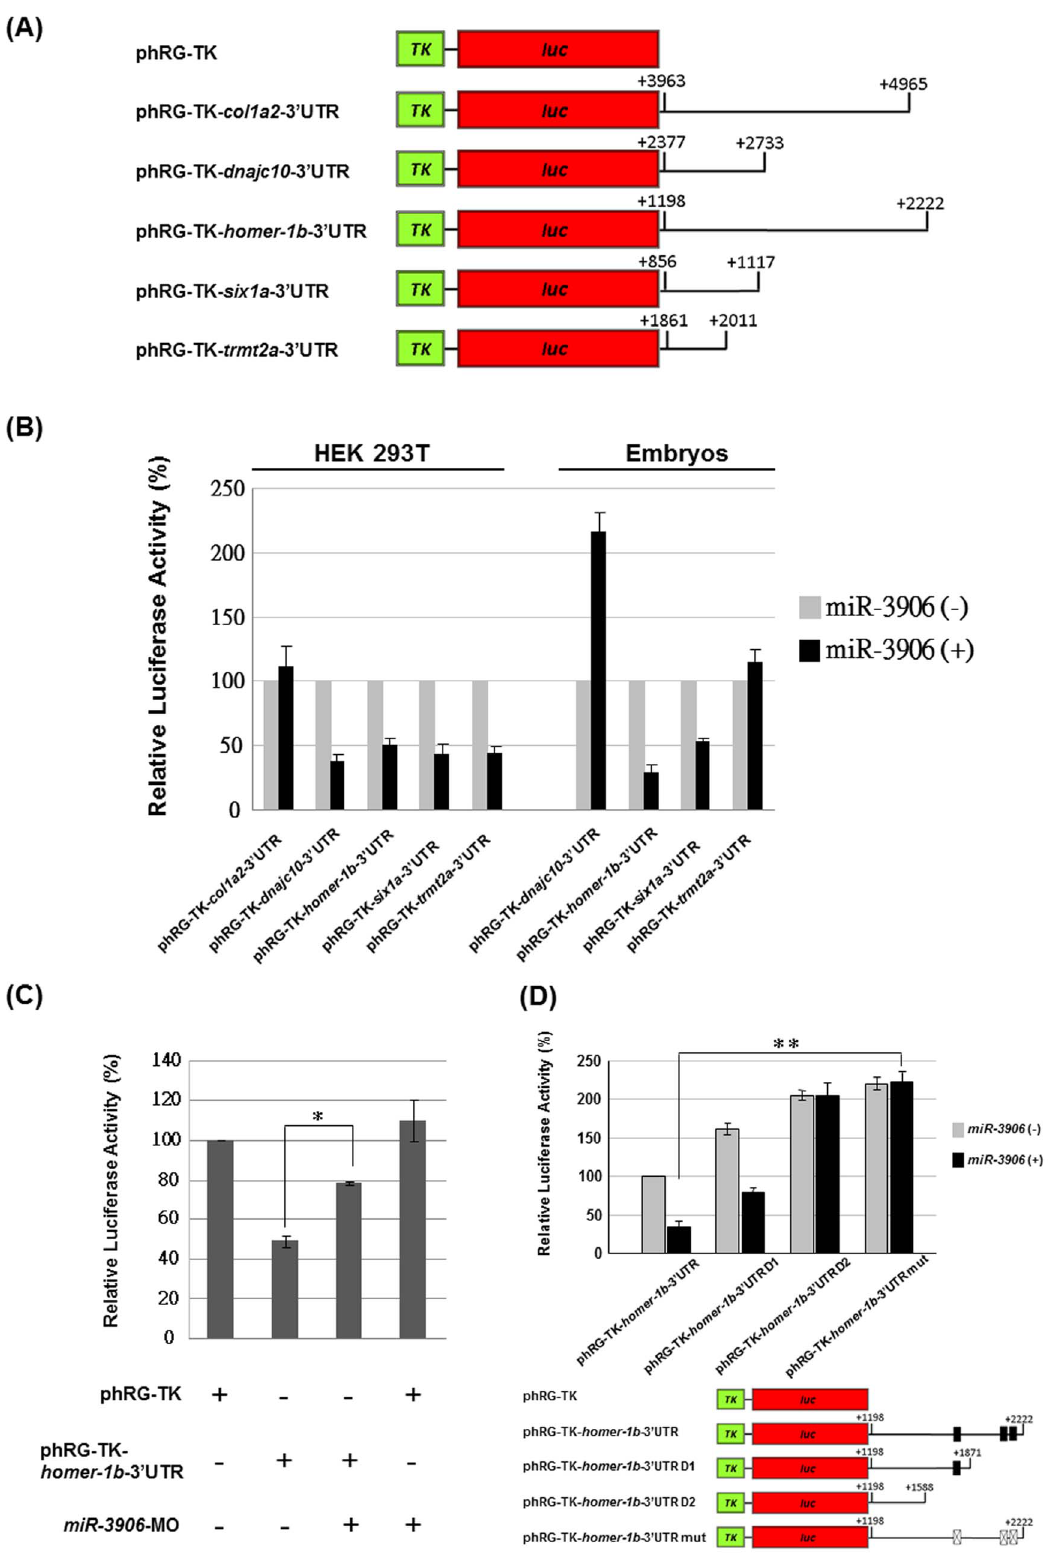
Figure 1. Luciferase ( luc ) activity assay of miR-3906 co-injected with plasmid constructs containing 3 9 UTR segment of putative miR- 3906 -target genes. ( A ) Constructs for examining luc assay. The complete 3 9 UTR segments of col1a2 , dnajc10 , homer-1b , six1a and trmt2a, which are putative target genes of miR-3906, were ligated into the downstream of luc reporter gene contained in plasmid phRG-TK. ( B ) Plasmid pCMV-RFP- miR- 3906 [ miR-3906 ( + )], a RFP reporter fused with pre- miR-3906 and driven by CMV promoter, was co-transfected with pGL3-TK (internal control) and each examined construct, as indicated, into HEK 293T cells. Injection of pGL3-TK and each examined construct without containing pCMV-RFP- miR-